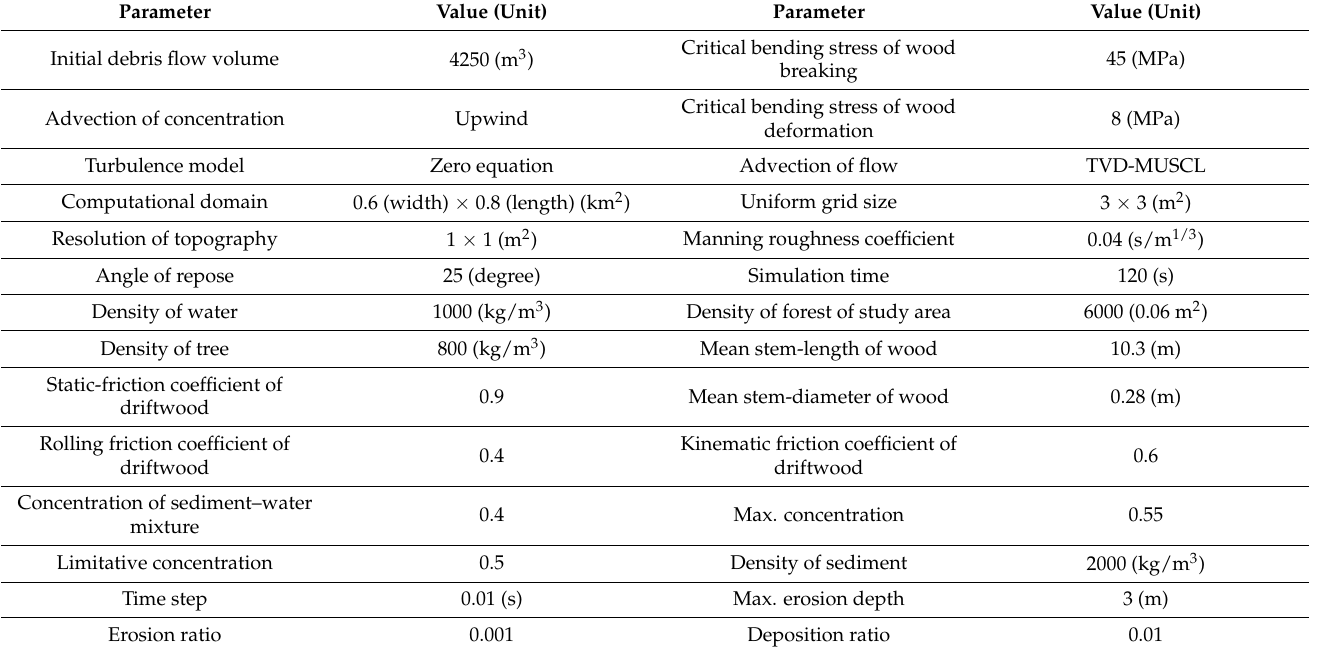
Table 1. Parameters of computational model and simulation cases.